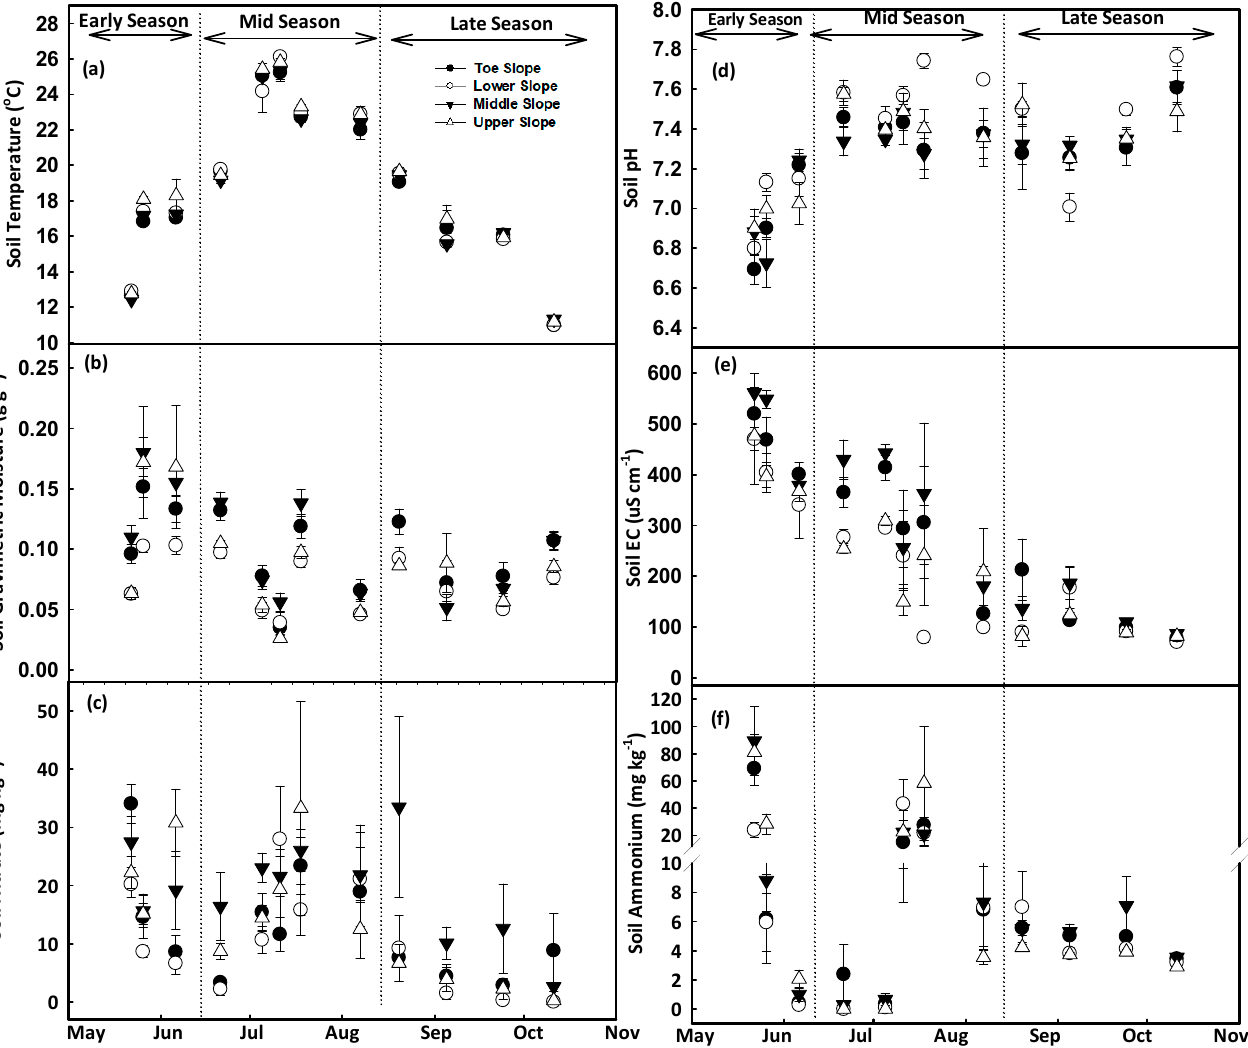
Figure 3. Temporal changes in soil temperature ( a ), gravimetric moisture content ( b ), nitrate ( c ), pH ( d ), electrical conductivity ( e ) and ammonium concentration ( f ) at Research North. Scatter plots were prepared using mean values (Mean ± SEM) from four replications at each slope positions. Soil samples were collected during early (22 May, 26 May, 6 June), mid (21 June, 5 July, 11 July, 18 July, 7 August), and the late growing season (20 August, 5 September, 24 September, 11 October).